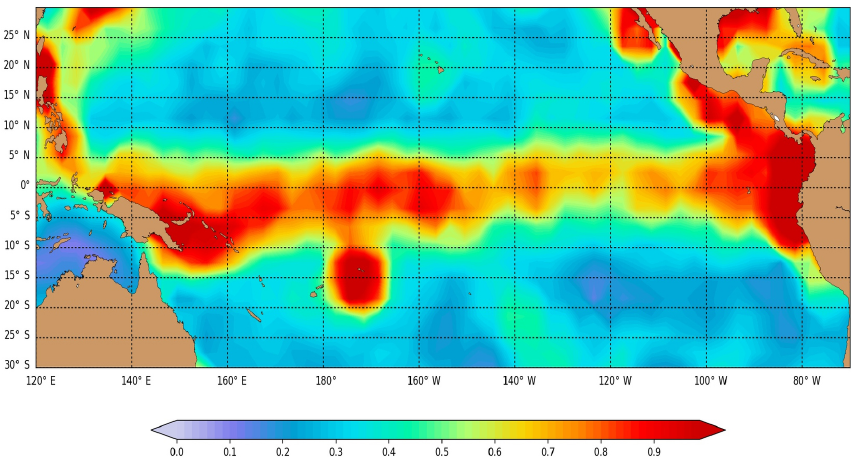
Figure 4. Example of the final product of Desroziers ratios r 5